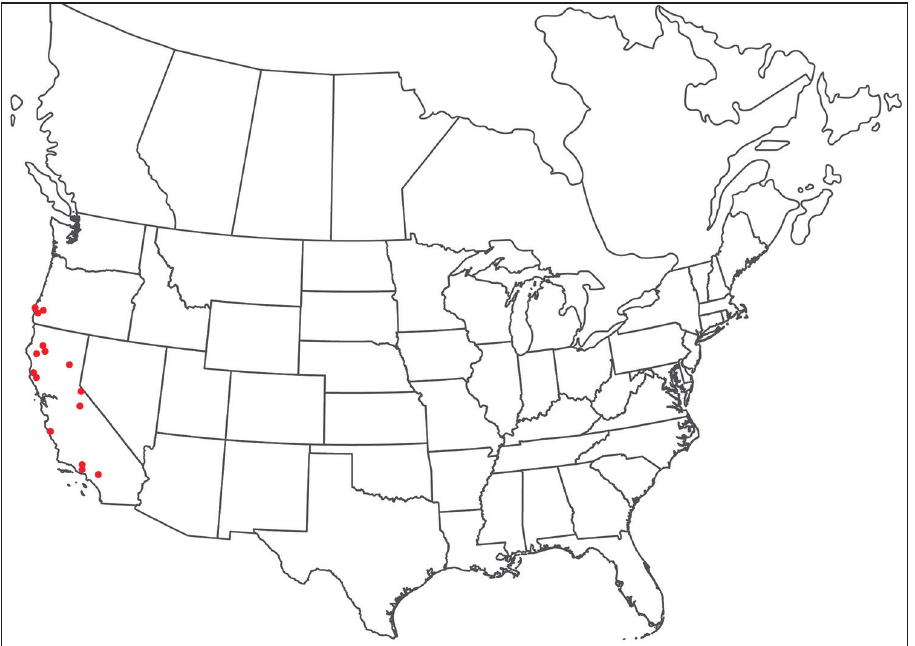
Figure 267. Torrenticola ventura